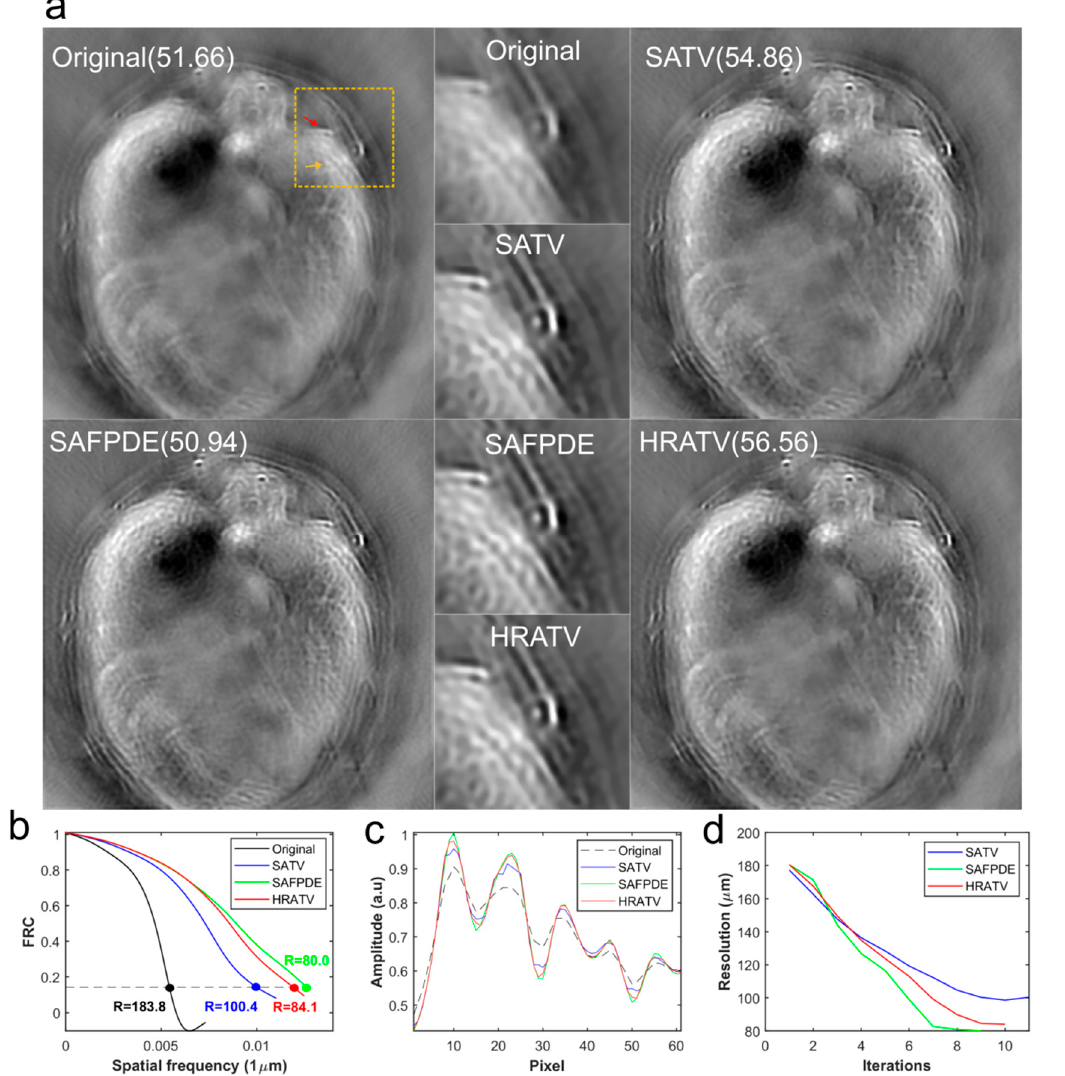
Figure 7. Deconvolution results of mouse liver. ( a ) Original image and images after deconvolutions. The vessel indicated by the red arrow is selected to calculate the SNR and the results are shown beside the image titles. ( b ) FRC measurements of the original image and the images after deconvolutions. ( c ) Line profiles of the vessels indicated by the yellow arrow. ( d ) Estimated resolution during iterations.